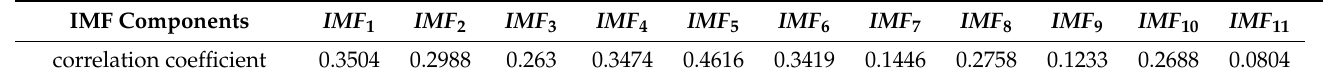
Table 2. The correlation coefficient of the IMF component.